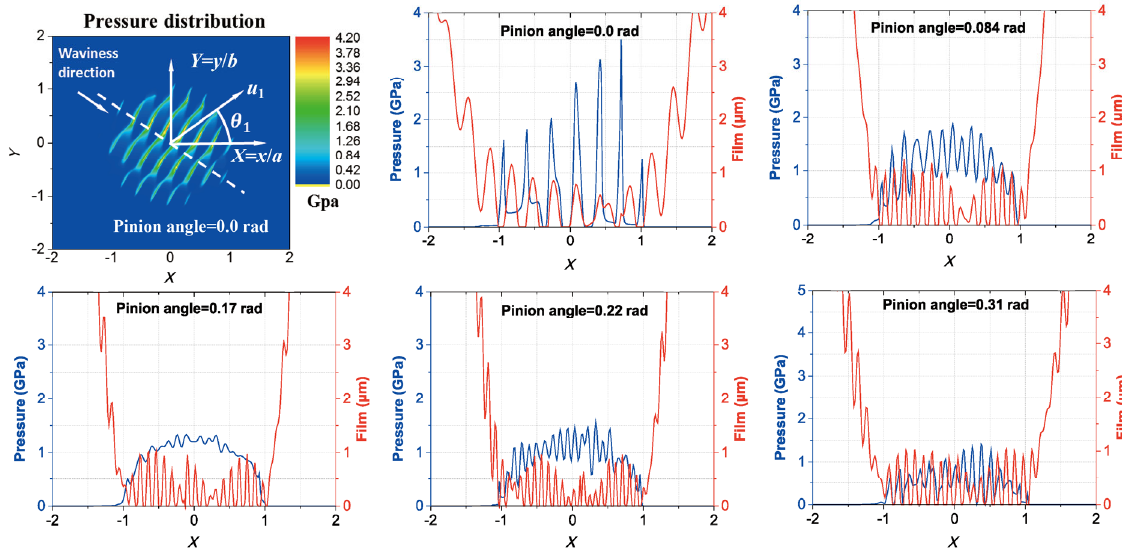
Fig. 11 Pressure distributions at different meshing positions.